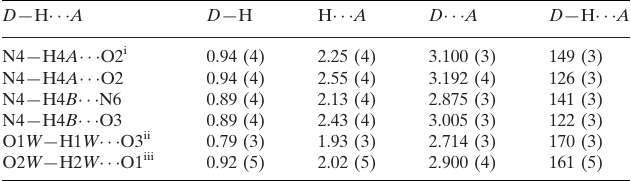
Hydrogen-bond geometry (A˚ , (cid:3)